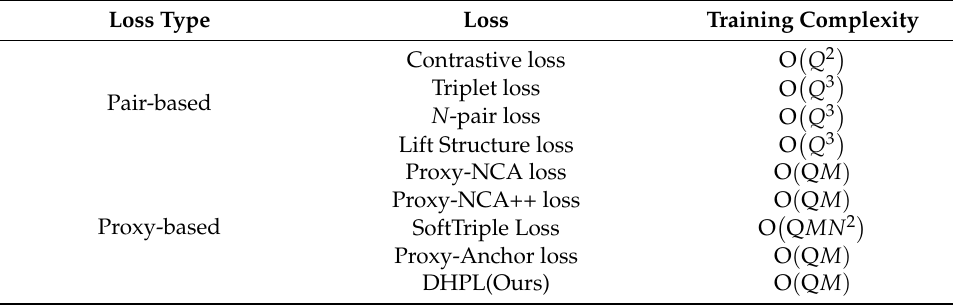
Table 1. Comparison of training complexity of different loss